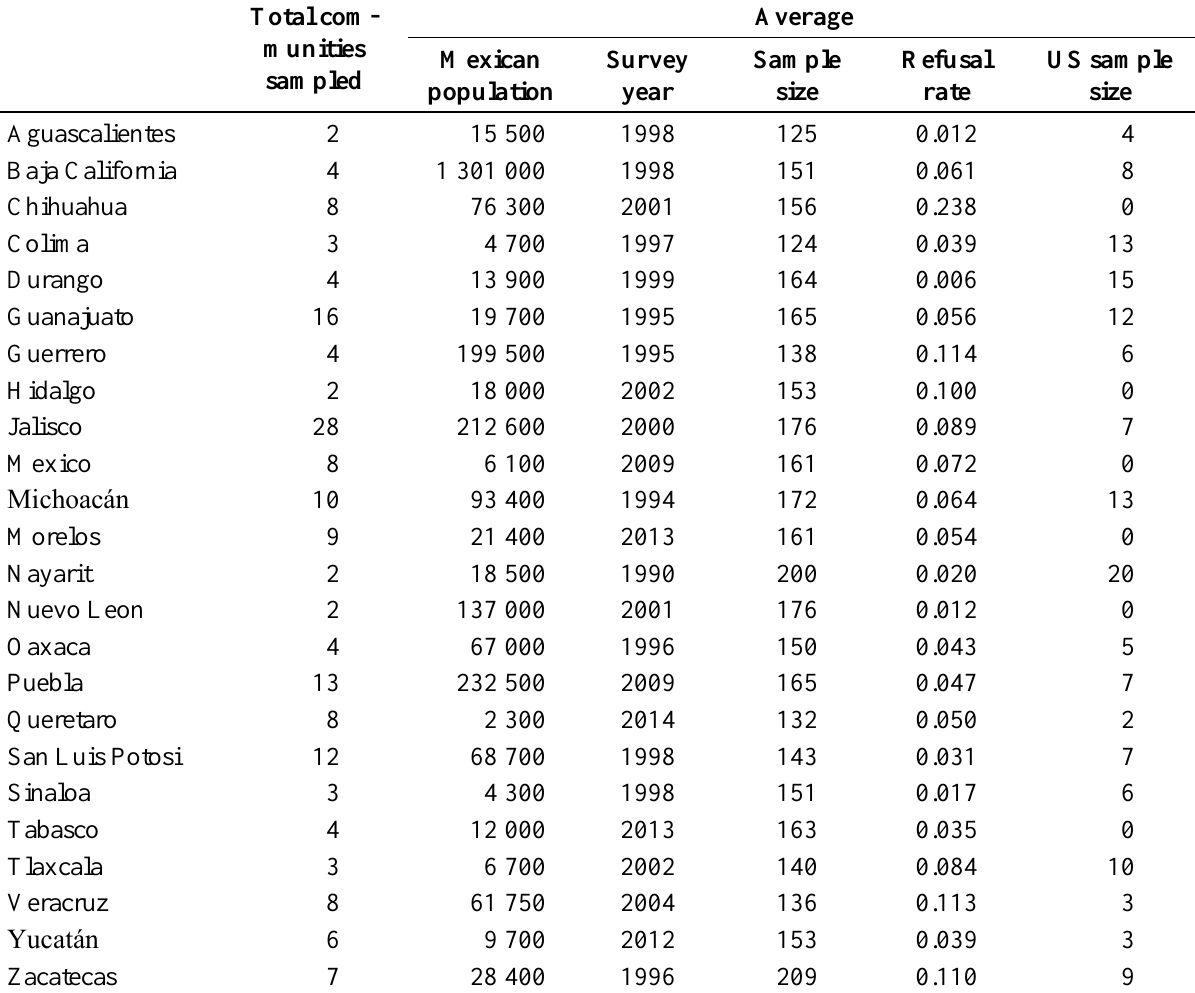
Table 1. Basic information on the ethnosurveys completed in Mexico